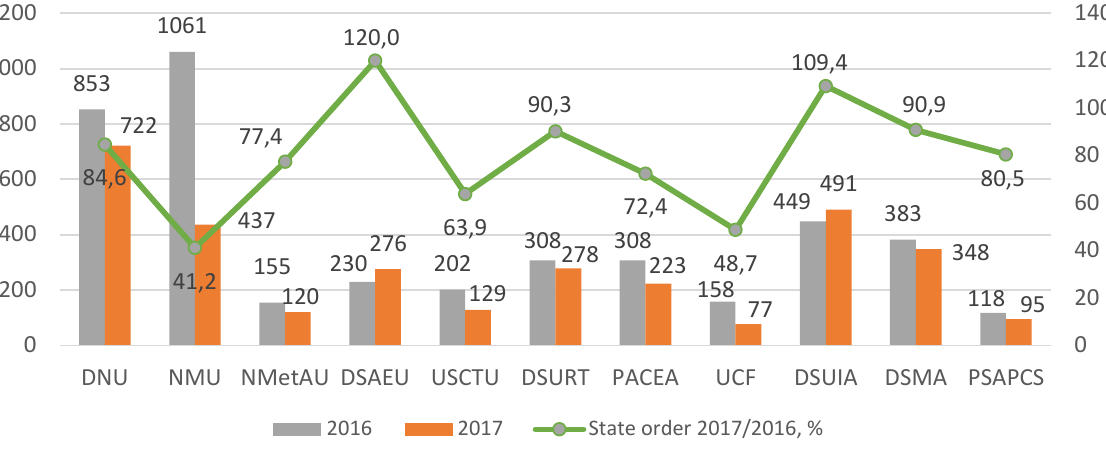
Figure 3. State order for HEIs of Dnipro for educational level